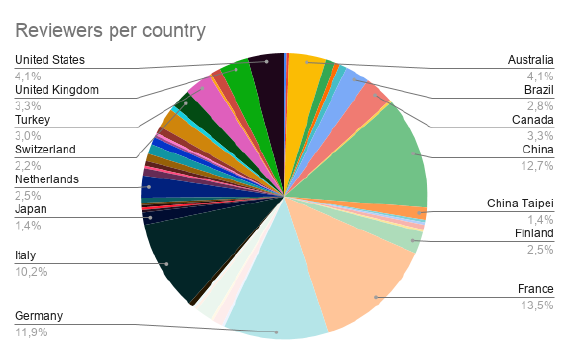
Figure 2. Reviewers per country.